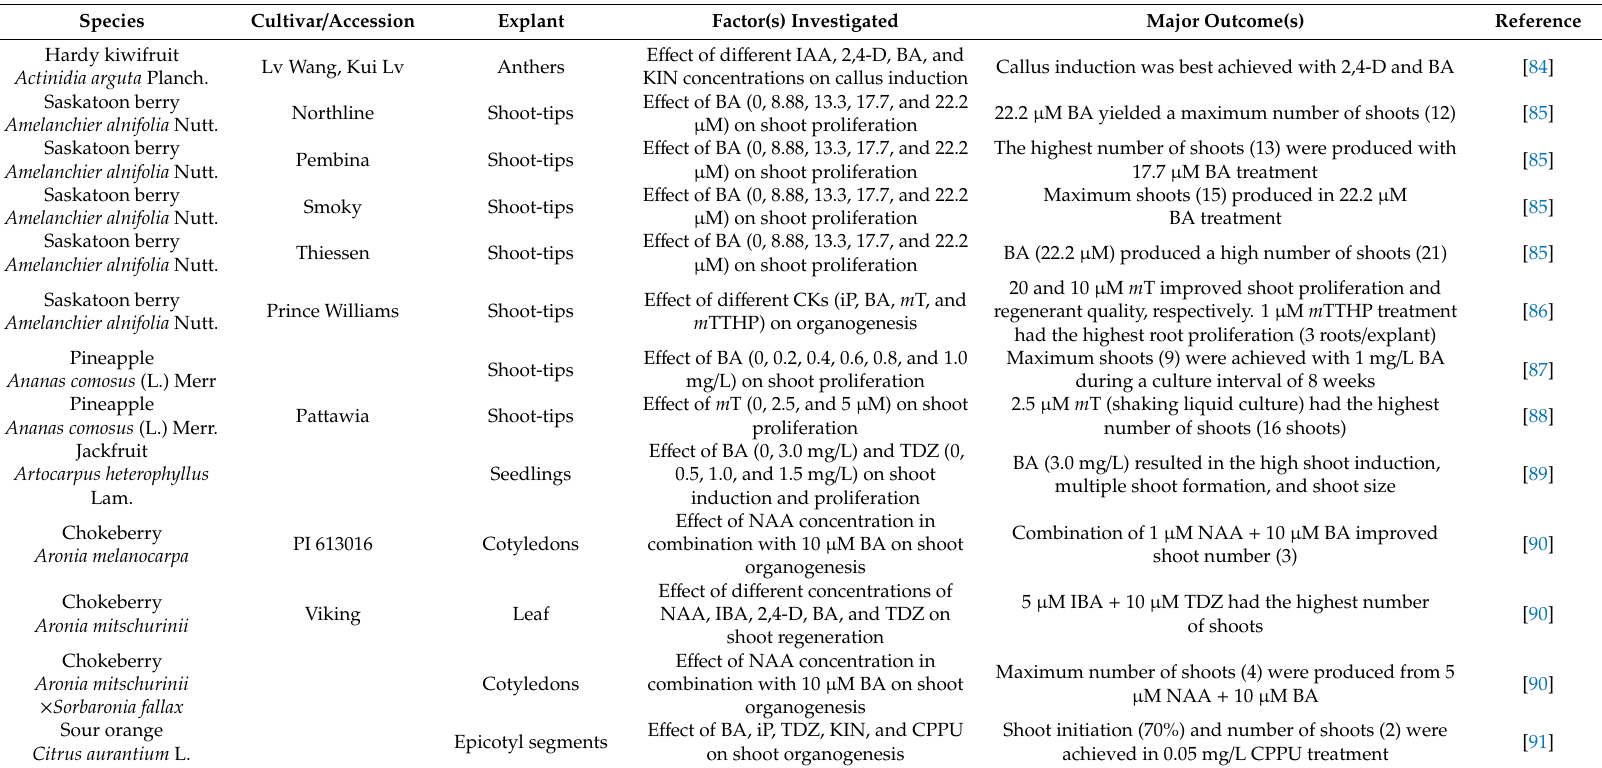
Table 2. Cytokinin applications for in vitro propagation protocols of horticultural fruit